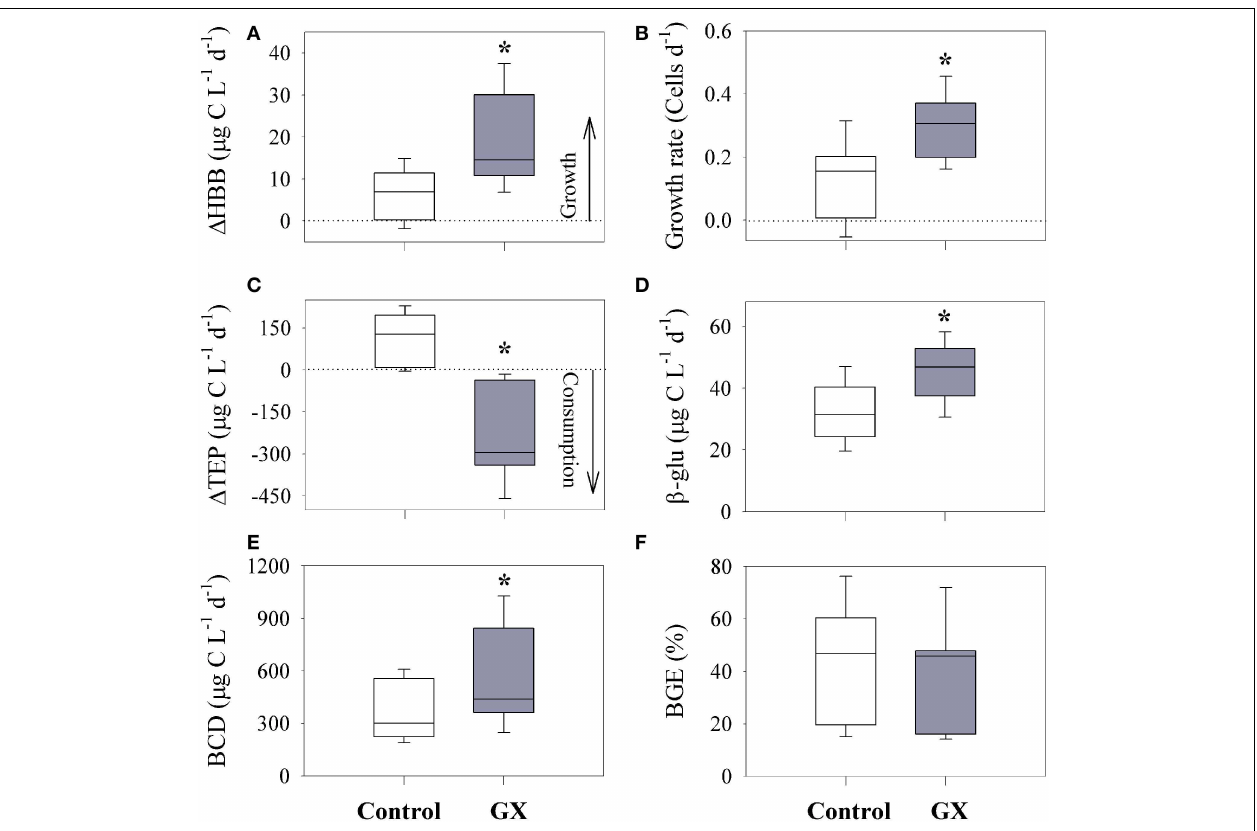
plot represents microcosms that were incubated with water samples from the surface and bottom of stations E1–E3. Box plot boundary are the 25th–75th percentile while the inner line represent median and whiskers highlight the 10th–90th percentile. Significant differences between control and GX enriched microcosms are marked with an asterisk ( P < 0 . 01